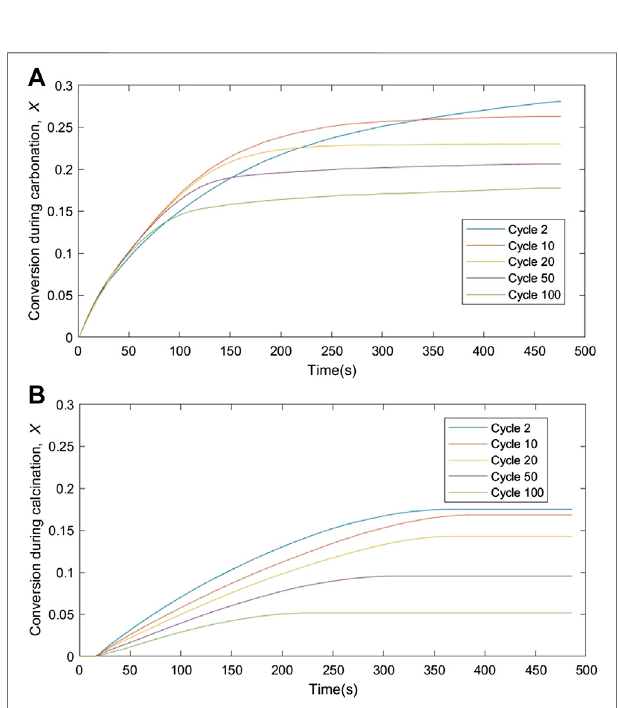
FIGURE 7 | Deconvoluted speci fi c rate of reaction during (A) carbonation and (B) calcination at various carbon capture - regeneration cycles.